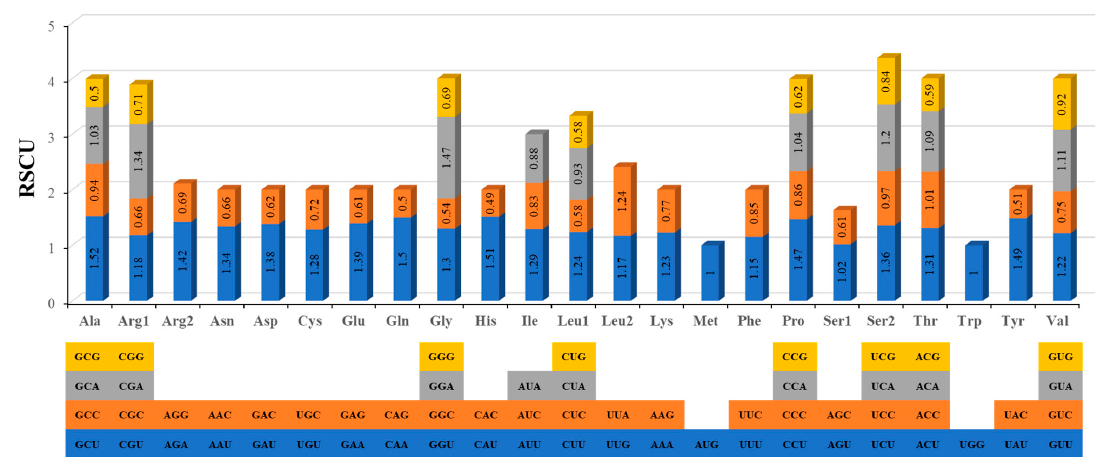
Figure 4. Relative synonymous codon usage (RSCU) of P. vulgaris mitogenome. Codon families are on the X-axis. RSCU values are the number of times of a particular codon, relative to the number of times that the codon would be observed for a uniform synonymous codon usage. Int. J. Mol. Sci. 2020 , 21 , x